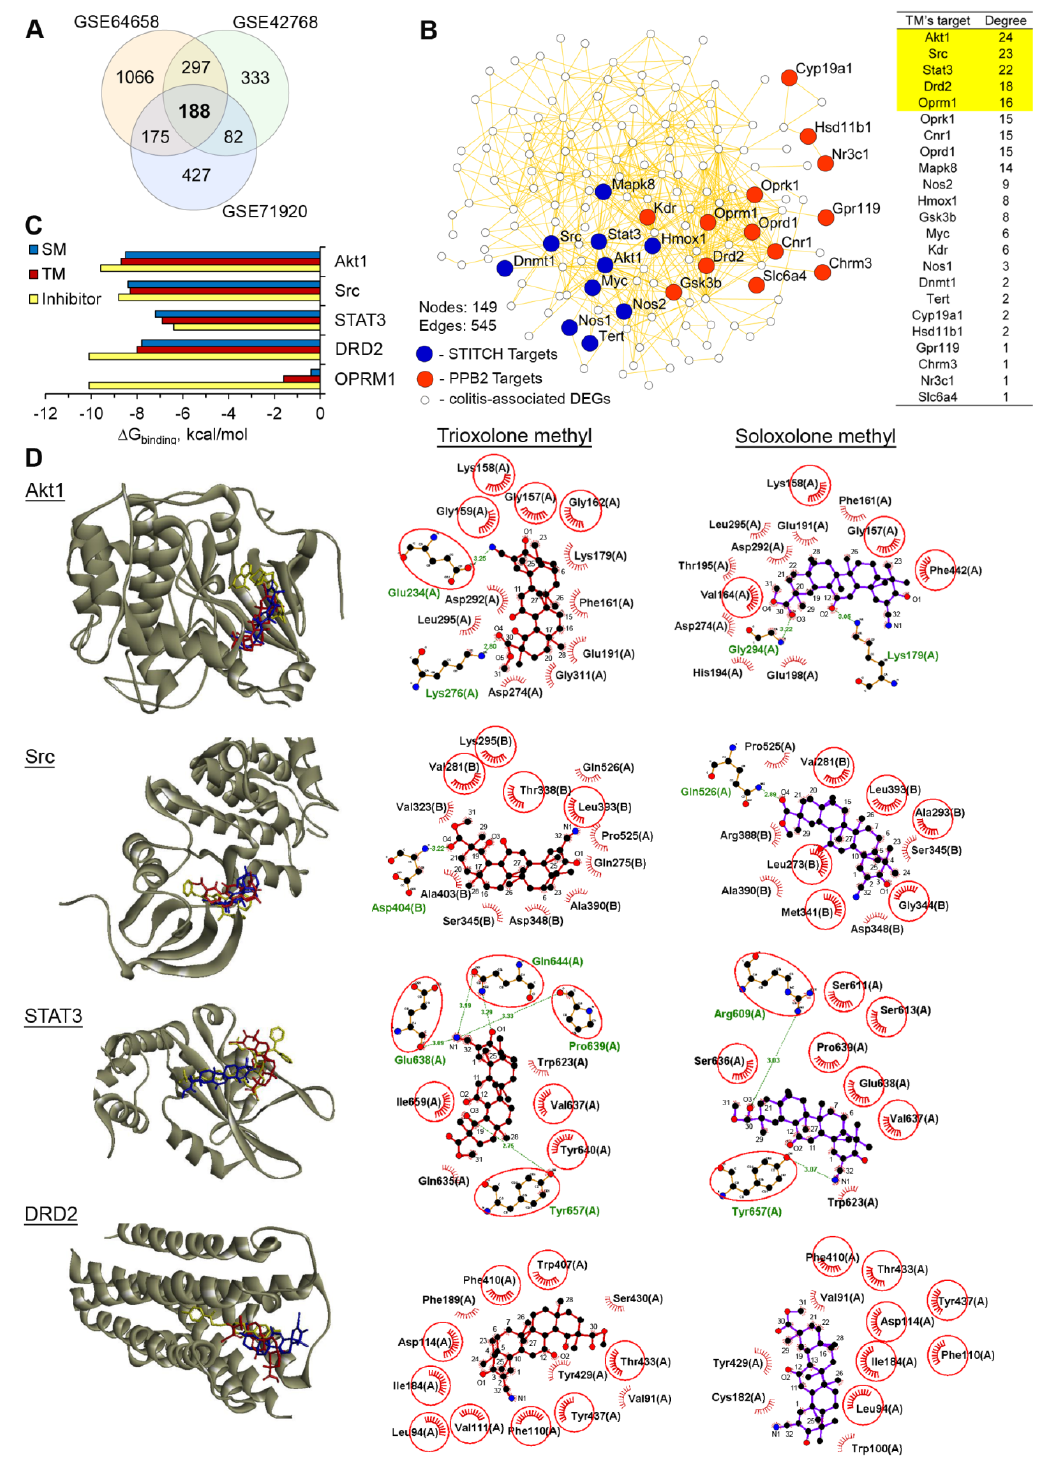
Figure 6. AKT serine / threonine kinase 1 (Akt1), tyrosine protein kinase Src, signal transducer and activator of transcription 3 (STAT3) and dopamine receptor D2 (DRD2) are probable primary targets of TM. ( A ) Venn diagram of the genes that were di ff erentially expressed in the DSS-inflamed colon tissues in comparison with the healthy control (fold change > 1.5, p < 0.05) identified by the re-analysis of the Gene Expression Omnibus (GEO) datasets. ( B ) The protein–protein interaction network containing the colitis-associated di ff erentially expressed genes (DEGs) and primary targets of TM, predicted by